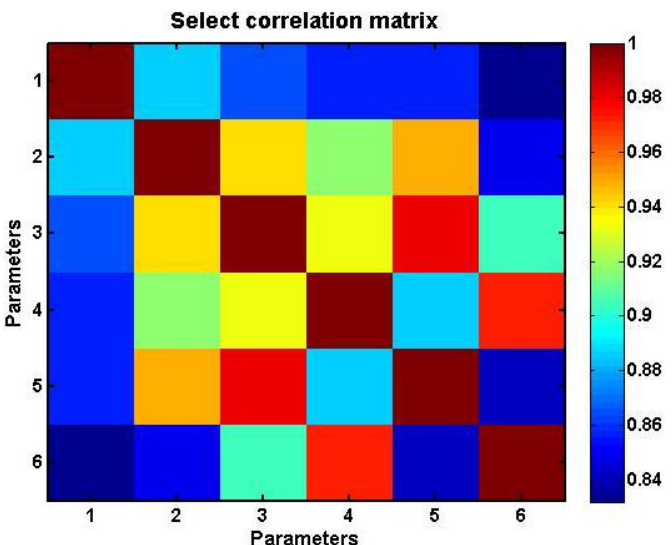
Figure 4. Tonal representation of the EURUSD correlation matrix and its five financial instruments with the highest correlations.